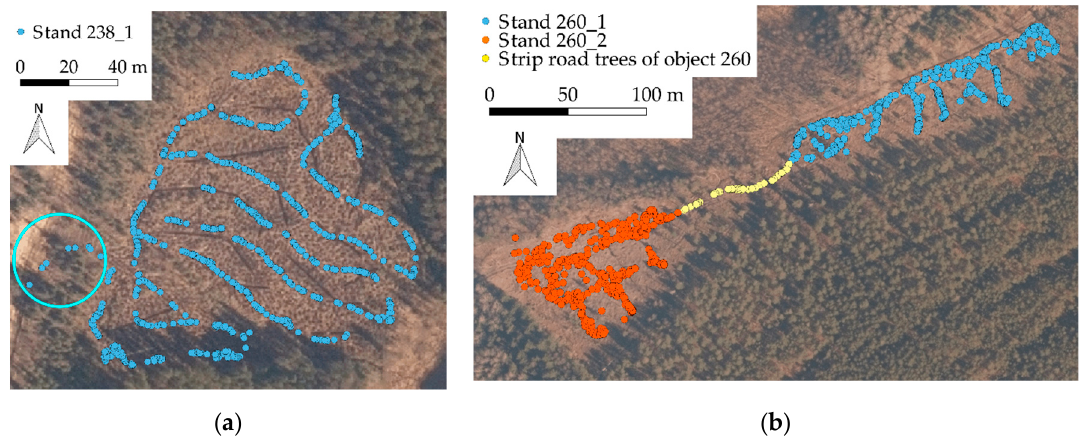
Figure 4. Averaged tree point data of harvested objects. The ETRS-TM35FIN (EPSG:3067) coordinate system is used in the figure. Aerial images © National Land Survey of Finland. ( a ) The external strip road is recognized as part of stand. GNSS positioning of harvester was more accurate. ( b ) The parts of stands which have only one strip road are recognized as external strip roads at final felling objects.